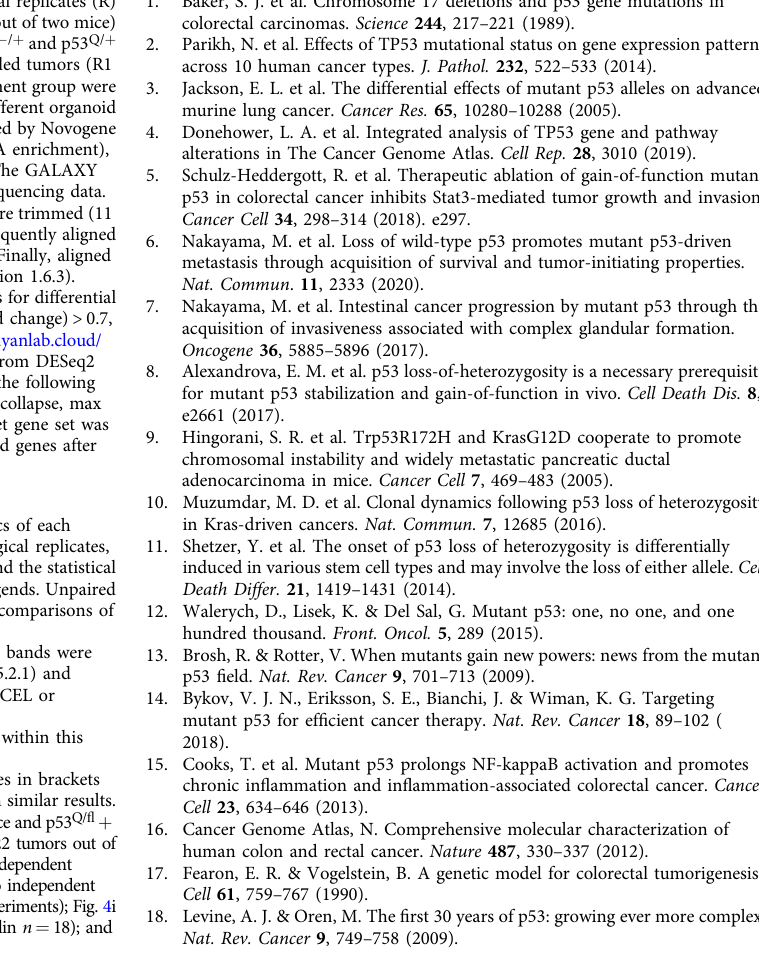
Supplementary Figure 1b (p53 − / + and p53 Q/ + mice n = 7 each, and p53 − / − and p53 Q/ − mice n = 16 each); Supplementary Fig. 1e (p53 Q/ − mice n = 16); Supplementary Fig. 1g (p53 Q/ fl + TAM mice n = 22 tumors out of three mice); Supplementary Fig. 1f ( n = 6 p53 Q/ fl + TAM tumors were analyzed); Supplementary Fig. 2o ( n = 8 different passages from three organoid cultures were analyzed); Supplementary Fig. 3b – d (two independent experiments); Supplementary Fig.